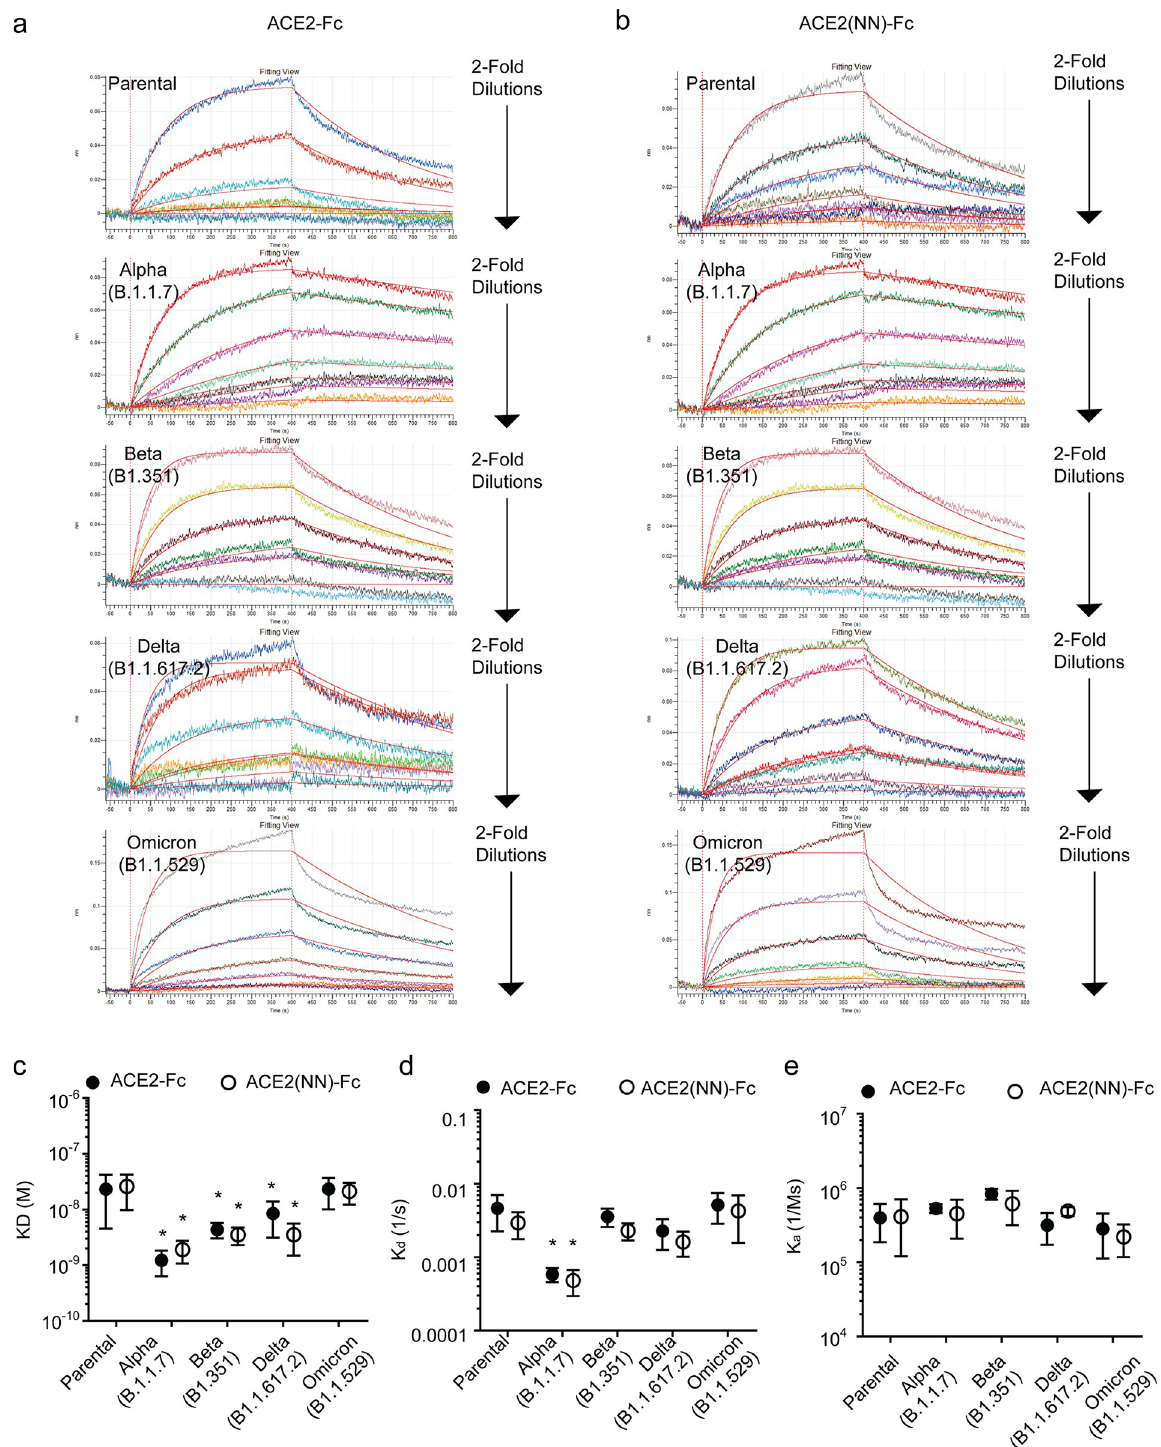
Fig 5. ACE2-Fc and ACE2(NN)-Fc binding affinity to S protein variants using biolayer interferometry. Representative electropherograms of ACE2-Fc ( a ) and ACE2(NN)-Fc ( b ) binding to S protein variants: parental, alpha, beta, delta, and omicron. The binding affinity ( c ), disassociation rate ( d ), and association rate ( e ) of ACE2-Fc to S protein variants: parental, beta, alpha, delta, and omicron. Three batches of ACE2 fusion proteins were analyzed in triplicate (Two Way ANOVA, Factors: Variant and ACE2 fusion protein, n = 9). Dots represent the mean and bars represent the 95% Cl. � indicate p < 0.05 within the ACE2-Fc or ACE2(NN)-Fc groups.